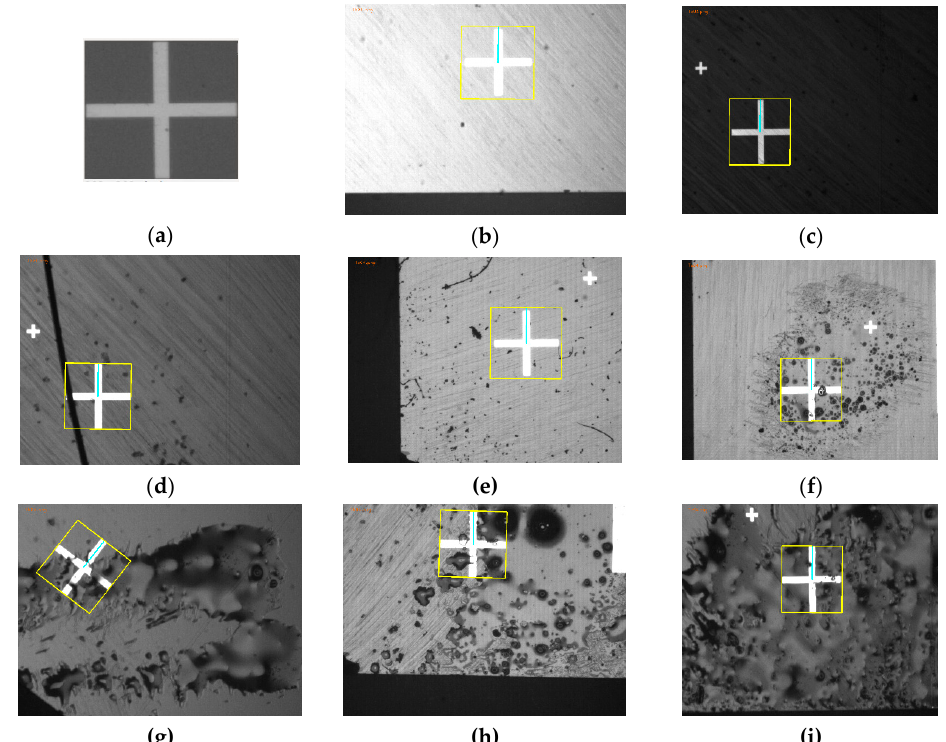
Figure 15. Matching results for the PCB cross-hair marks under different environmental conditions. (a) Cross-hair mark template (303 x 303 pixels). From (b) to (c), the test images have a size of 1280 × 960 pixels, in which: (b) and (c) are the matching results obtained under the bright and dark conditions, respectively ; (d) and (e) are the matching results obtained for foreign object placement inside the targets; (f), (g), (h) and (i) are the matching results obtained for targets affected by stains and smudges.